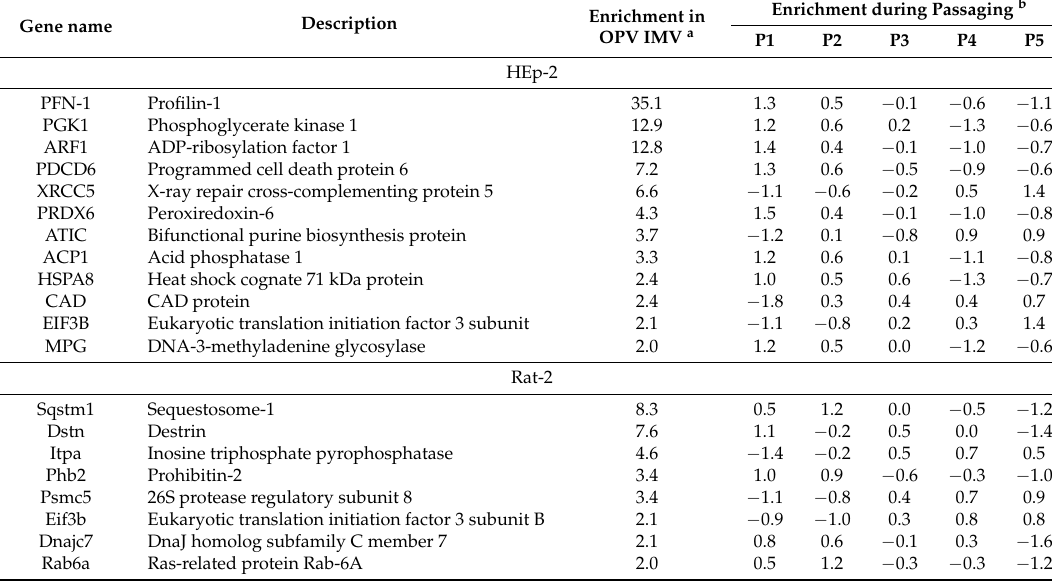
Table 3. CPXV mature virion-associated host proteins that changed during